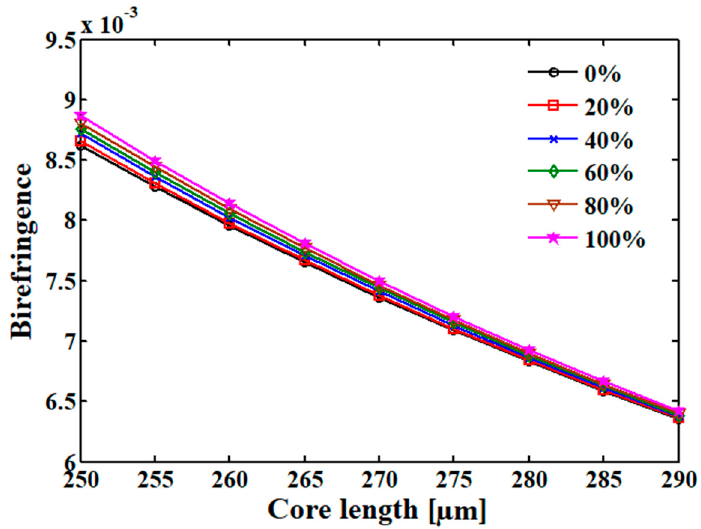
Figure 7. Birefringence of the proposed fiber for different core length to width ratio at f = 2.8 THz for different volume of kerosene with petrol.